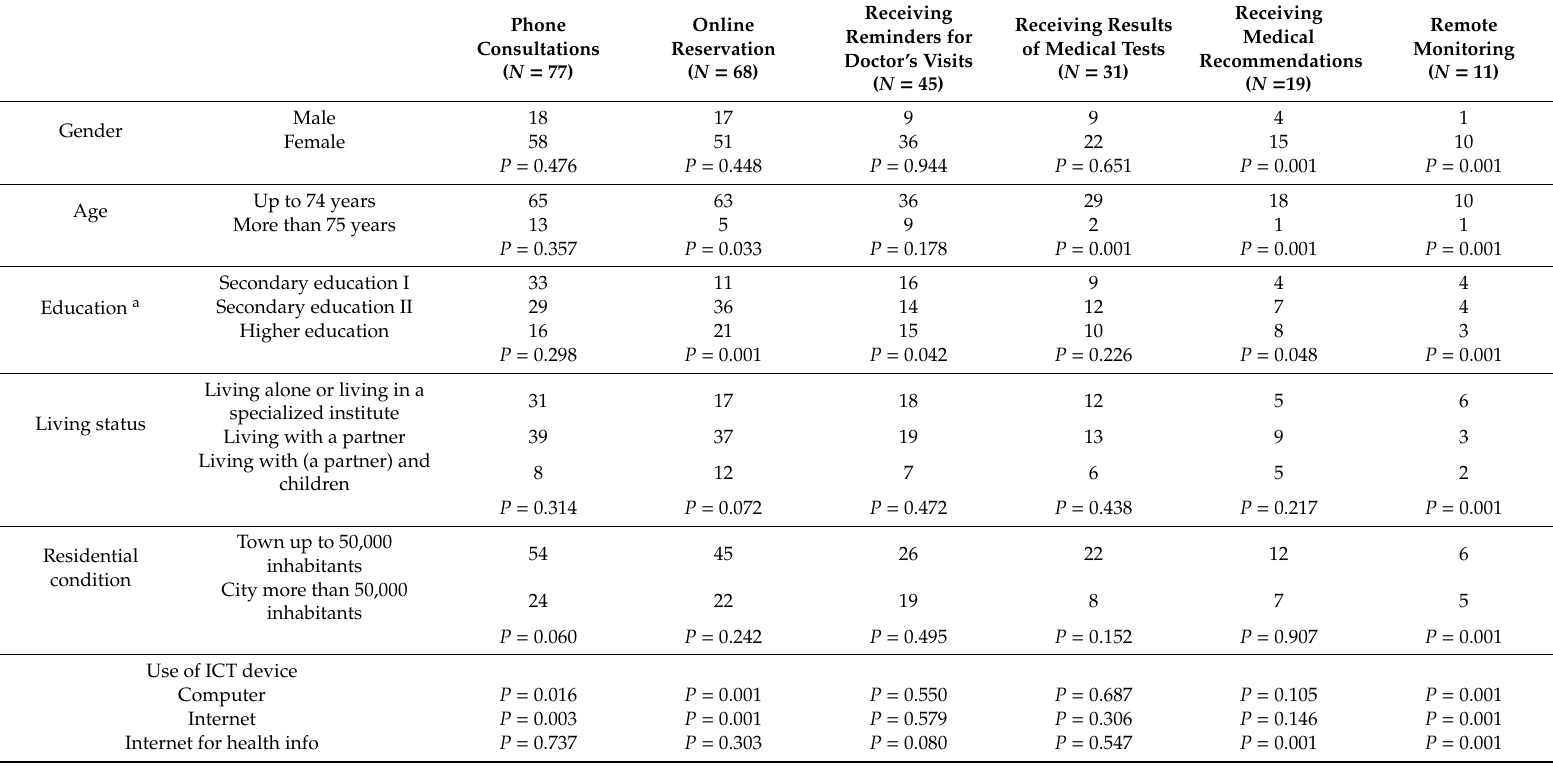
Table 6. Preference for e-Health services among the e-Health supporters ( N =